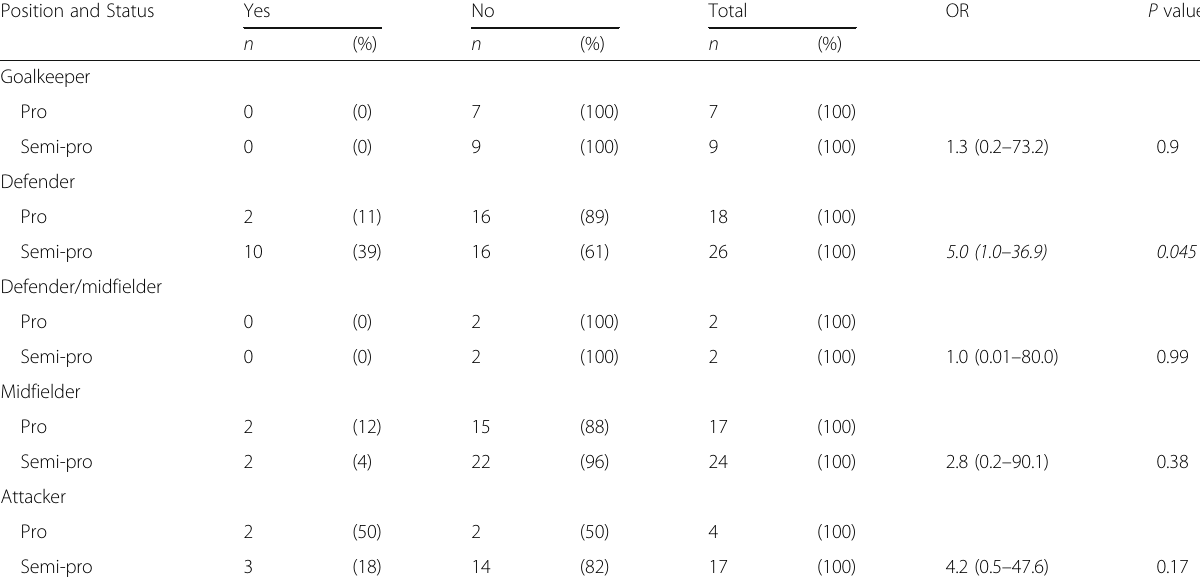
Table 1 Self-reported concussion associated with playing position and professional status Position and